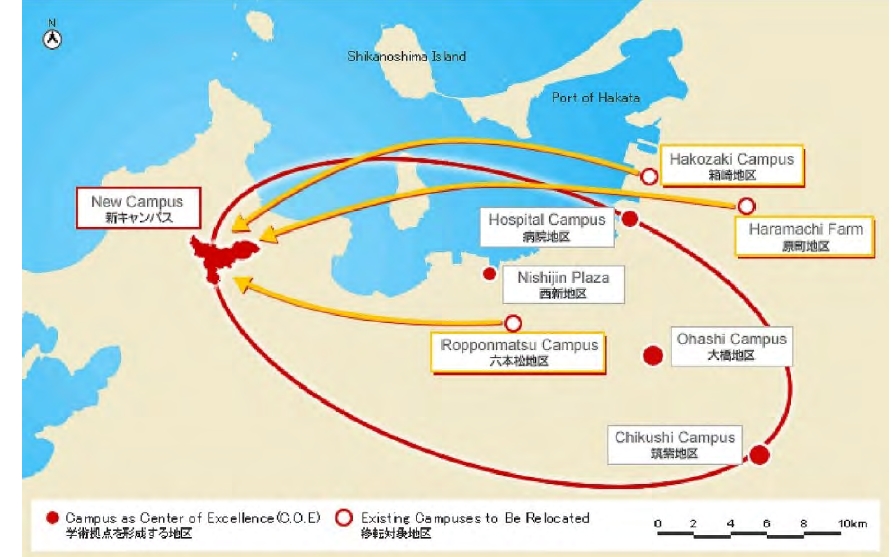
Figure 1. Campus Unification and